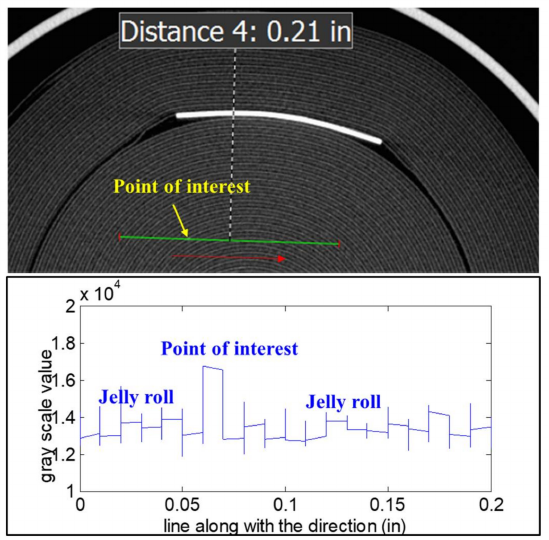
Figure 17. CT scan of the sample B1.